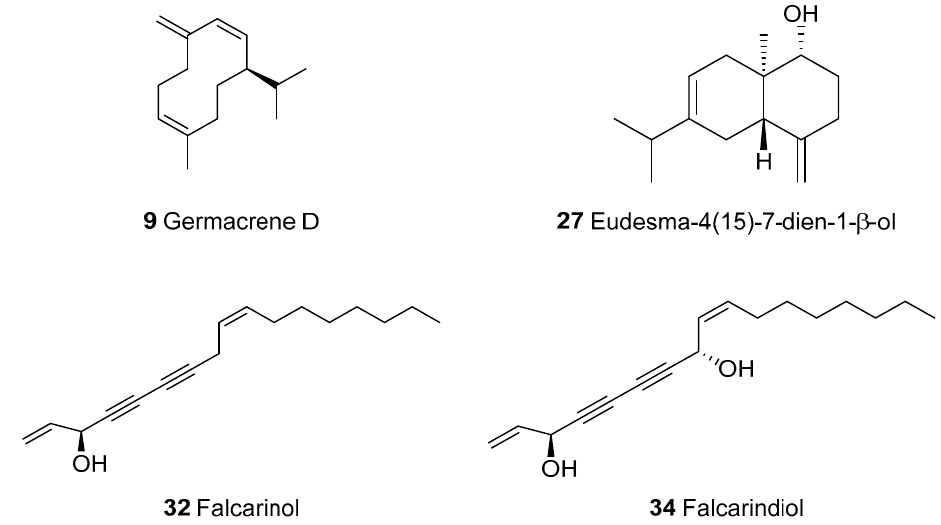
Figure 2. The main components identified in the hexane extract of E. campestre, from Algeria. Table 1. The chemical composition of the hexane extract of Eryngium campestre (HEEC). No.